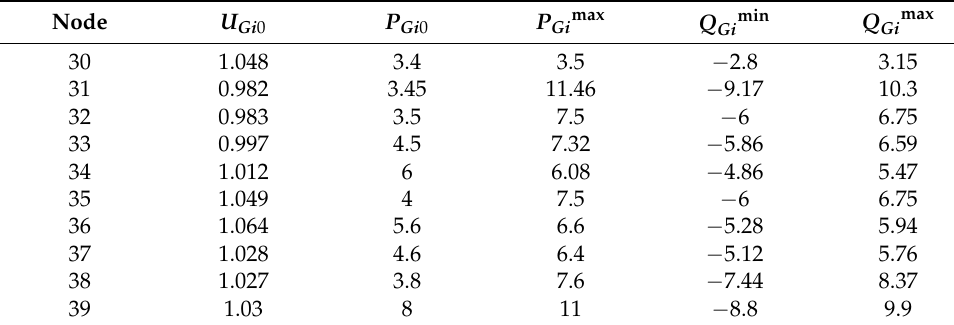
Table 4. Initial operating load